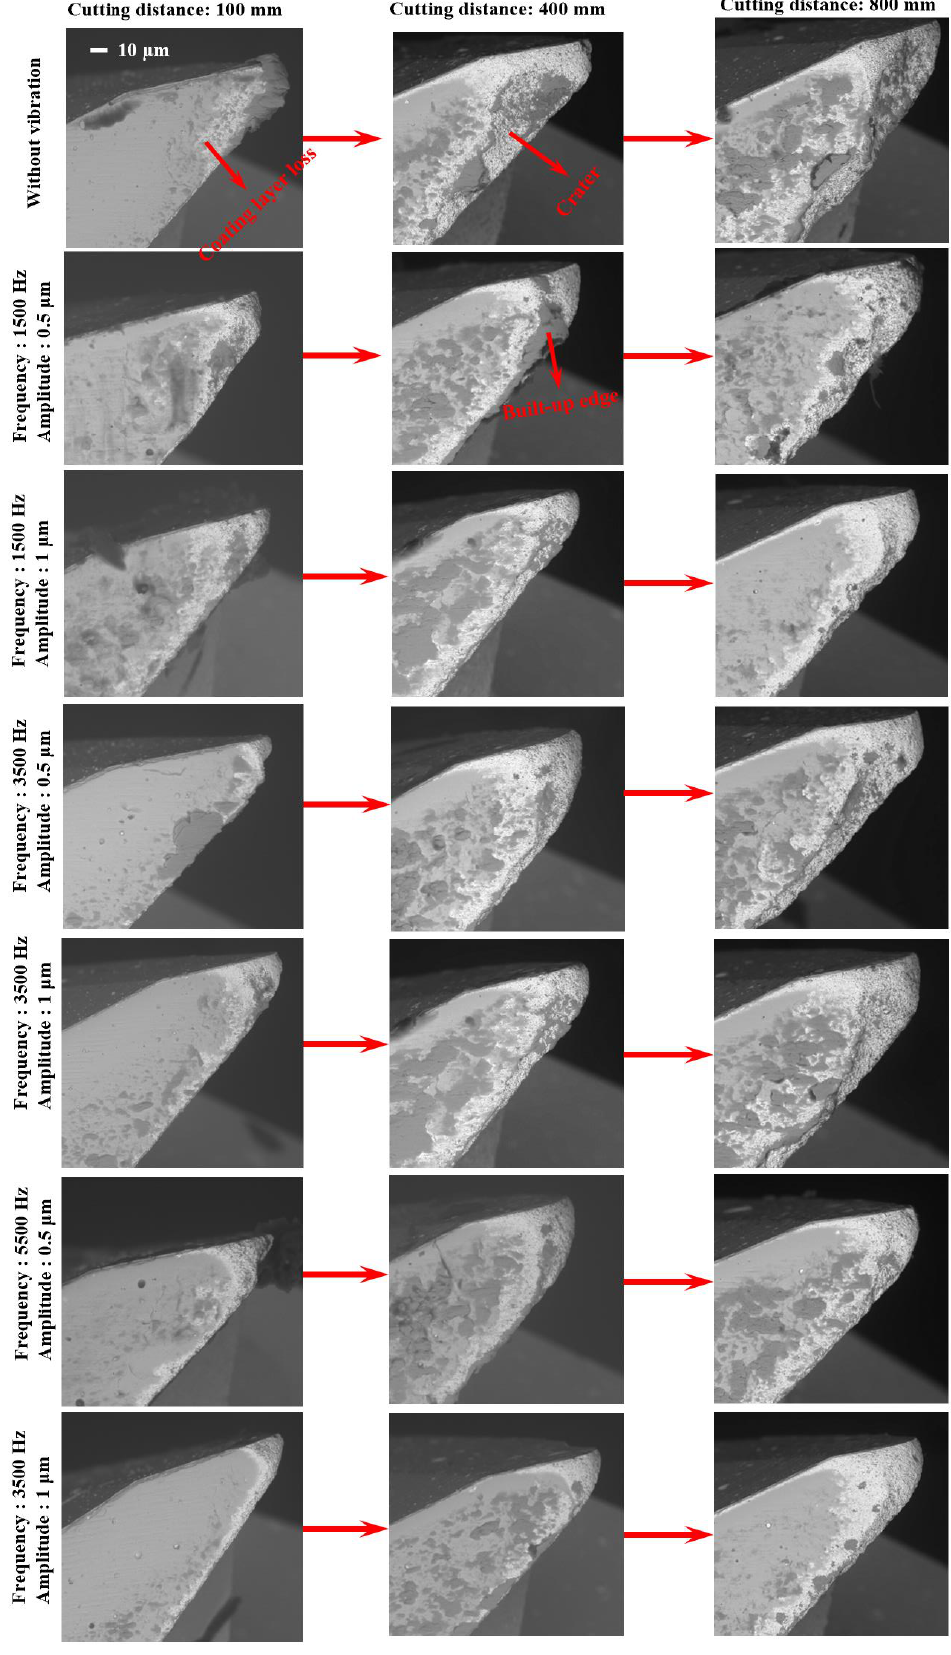
Figure 10. SEM results of flank face for the worn tools under different vibration conditions and different cutting lengths.